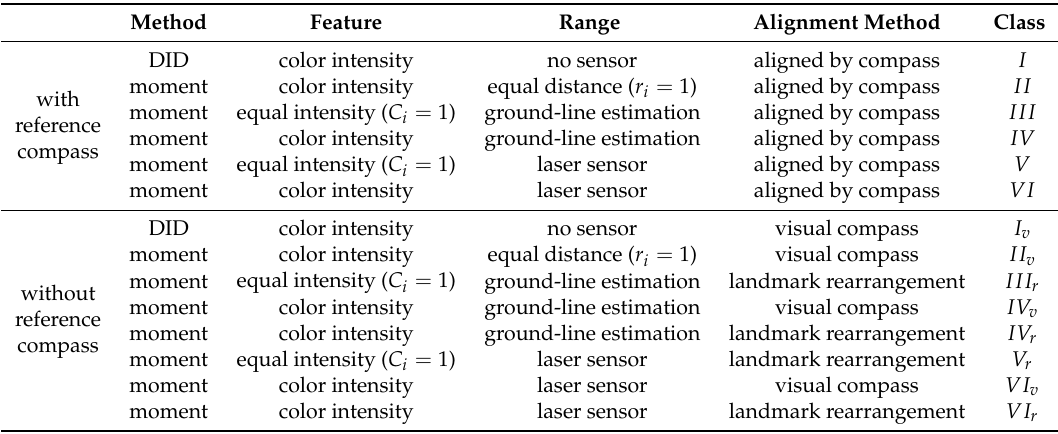
Table 1. Various methods classified by the feature, the range sensor and the alignment